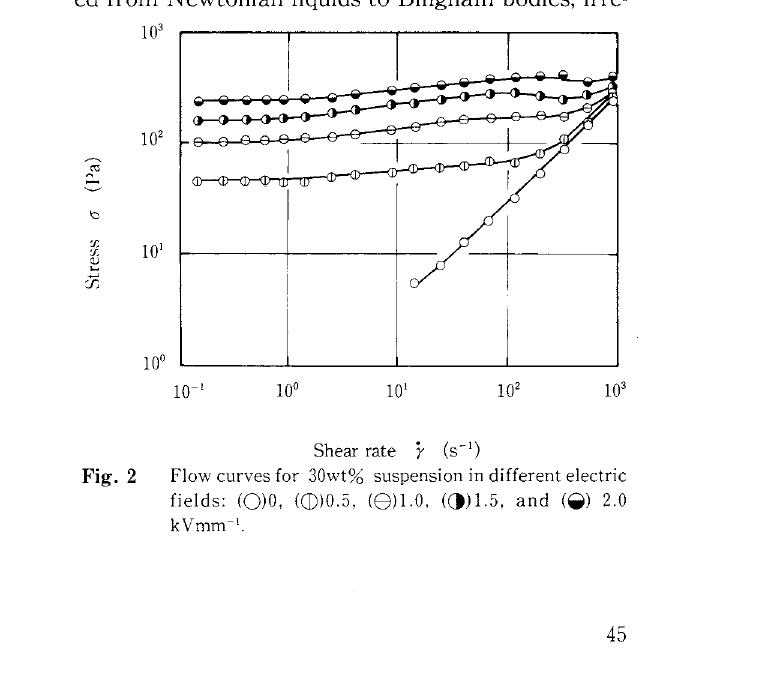
Microphotograph of composite particles coated with titanium hydroxide particles.